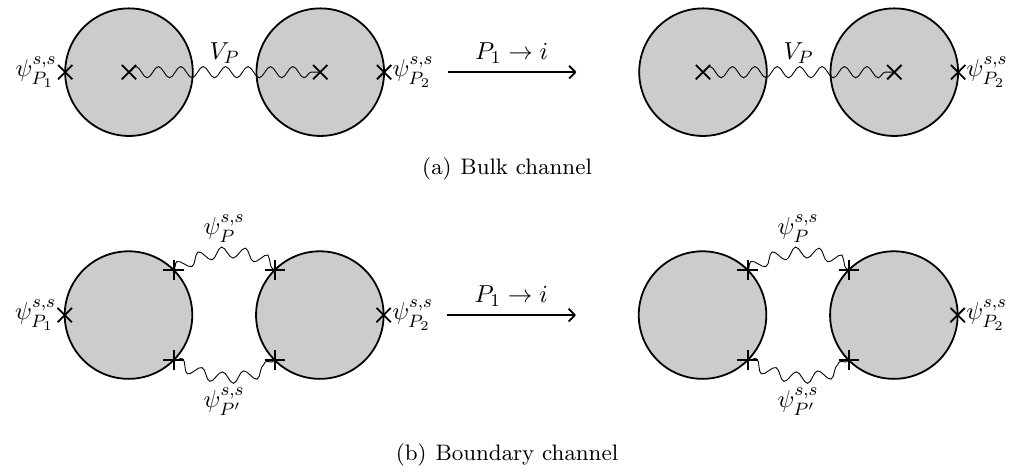
Figure 17 . The two channels of the cylinder two-point function. In the limit P 1 ! i , the cylinder two-point function becomes a cylinder 1-point function (up to a numerical